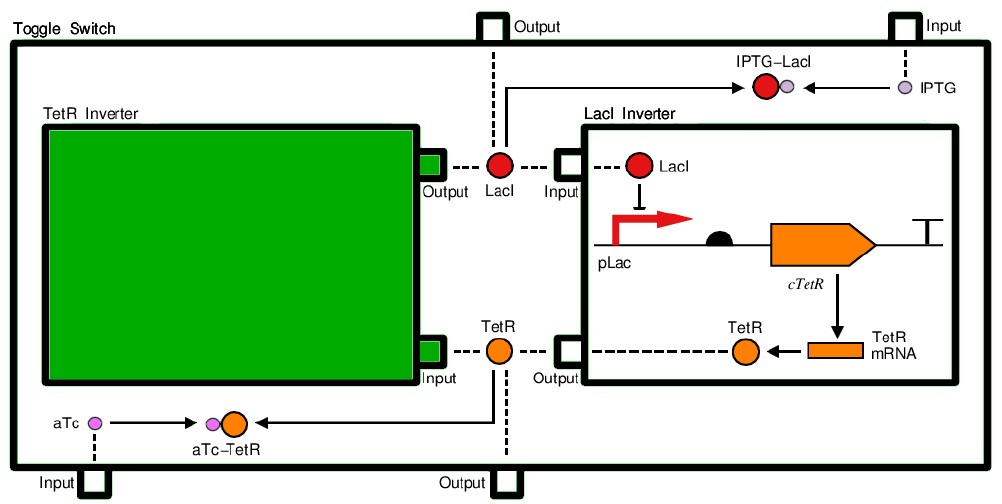
Figure 24: Design of a LacI/TetR toggle switch. This design is composed of two inverter sub-designs, each containing a single gene. These genes mutually repress each other’s expression via their encoded protein transcription factors, LacI and TetR. Furthermore, both LacI and TetR are bound by specific small molecules that sequester them and prevent them from acting as repressors. In this design, arrows represent different molecular interactions, including the repression of pLac via LacI, the non-covalent binding of IPTG to LacI, the transcription of TetR mRNA, and the translation of TetR. Dashed lines serve to map between transcription factors in the inverter sub-designs and those in the overall toggle switch design.